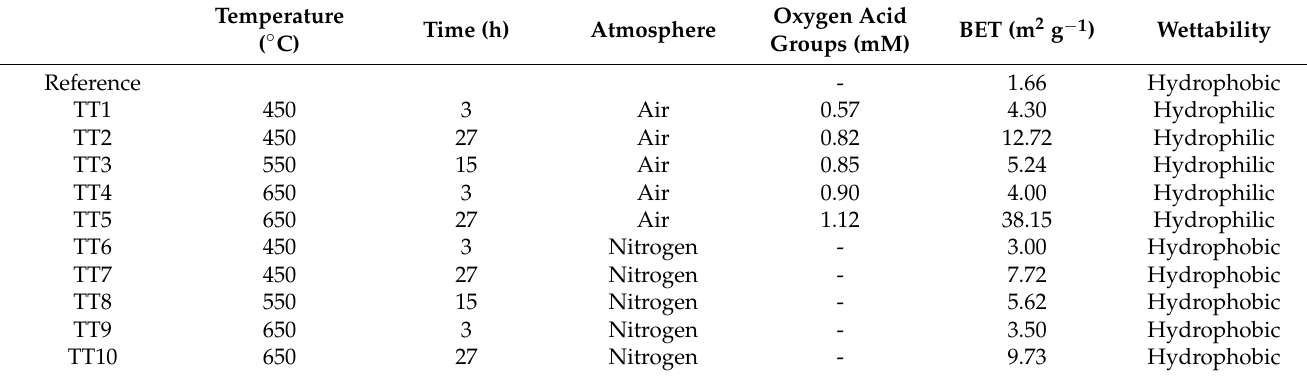
Table 1. Experimental conditions and measured parameters for thermally treated